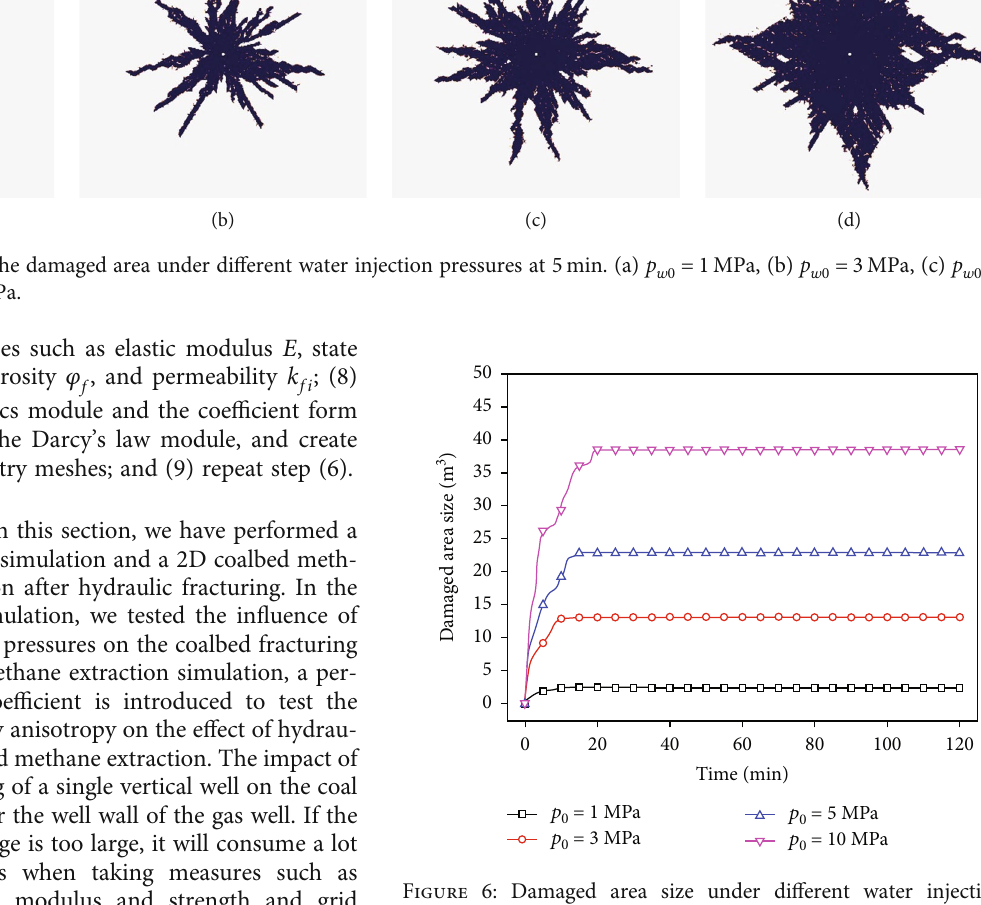
Figure 6: Damaged area size under di ff erent water injection pressures.